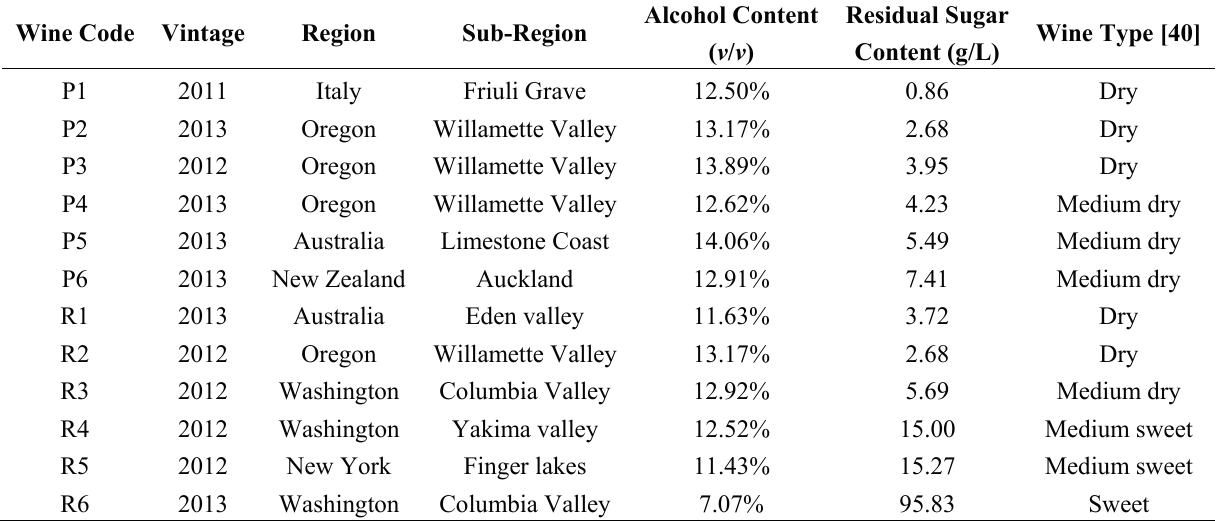
Table 7. Riesling and Pinot Gris white wine samples from different